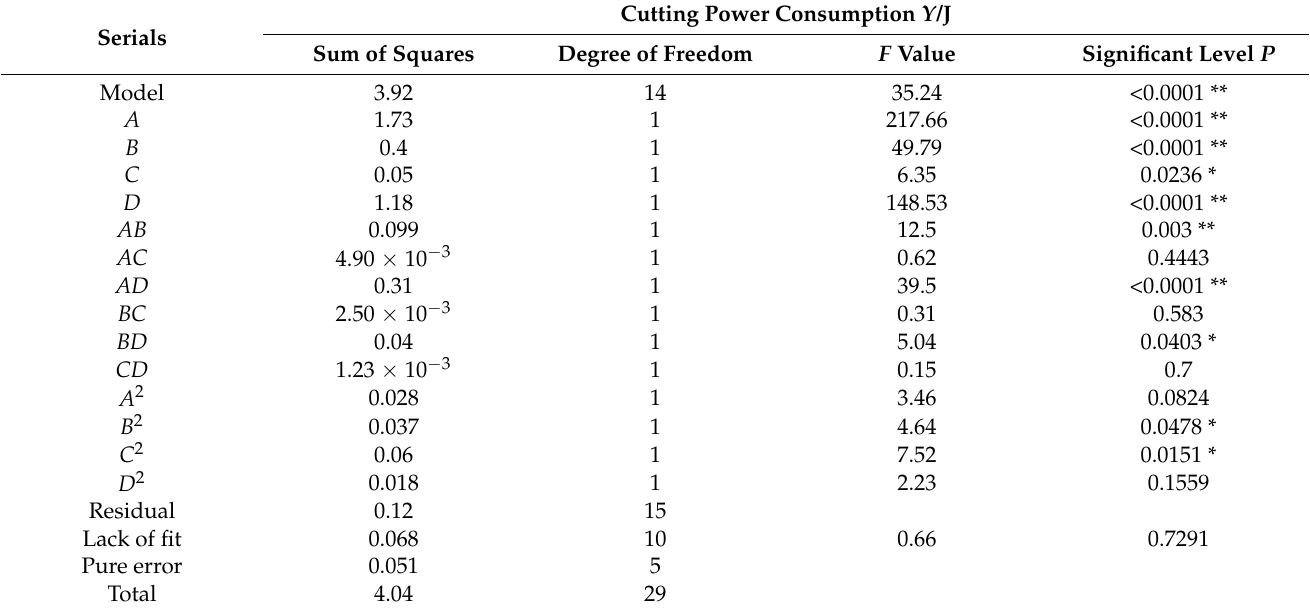
Table 4. Variance analysis of regression